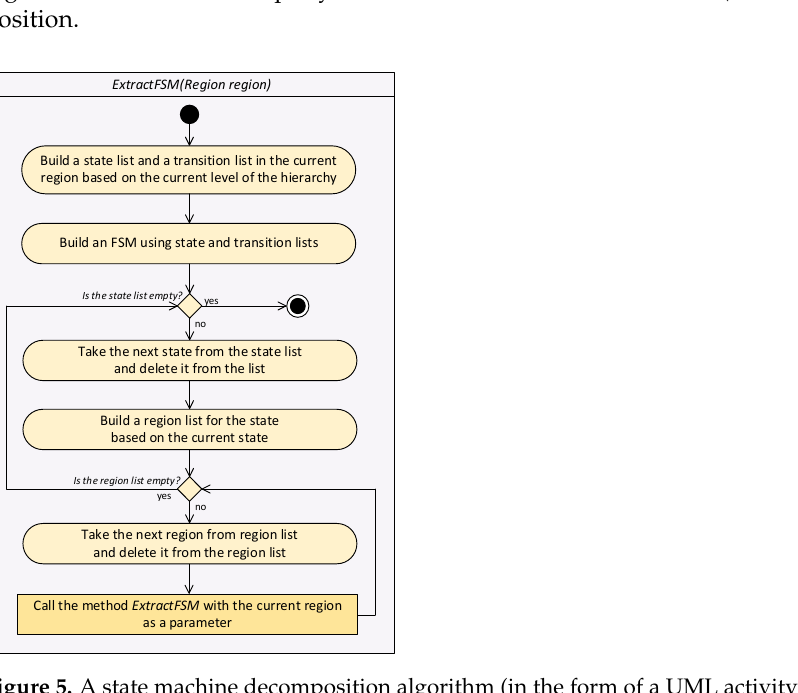
Figure 5. A state machine decomposition algorithm (in the form of a UML activity diagram).